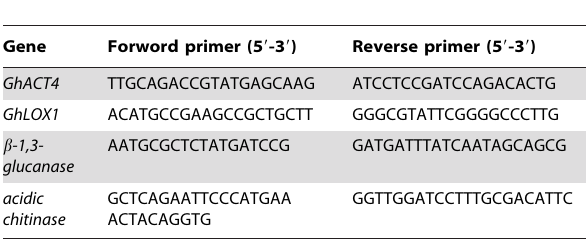
Table 1. Primer sequences used for qPCR